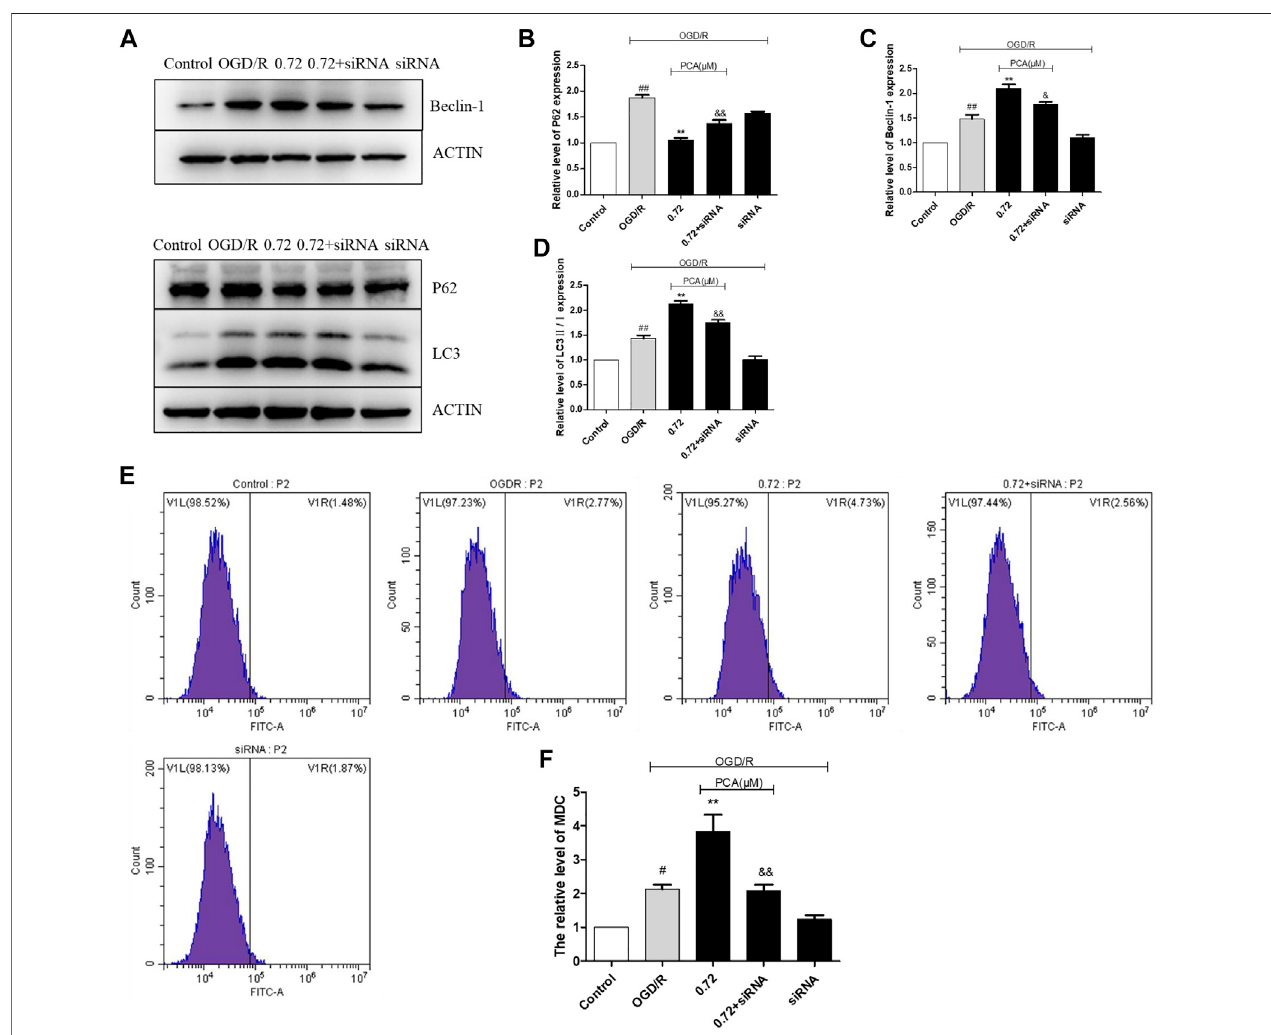
FIGURE11| InhibitionofSIRT1bysiRNA attenuatesthepro-autophagy effectofPCA. (A – D) RepresentativeimagesofWBanalysisandthesemi-quanti fi cationof P62, Beclin-1 and LC3 in HUVECs. (E, F) Representative images of fl ow cytometry analysis of PCA in fl uence and quanti fi cation of cell autophagy rate. The values are expressed as the mean ± SD ( n = 3). ## p < 0.01, # p < 0.05 vs. Control, ** p < 0.01 vs. OGD/R, && p < 0.01, & p < 0.05 vs. PCA 0.72 μ